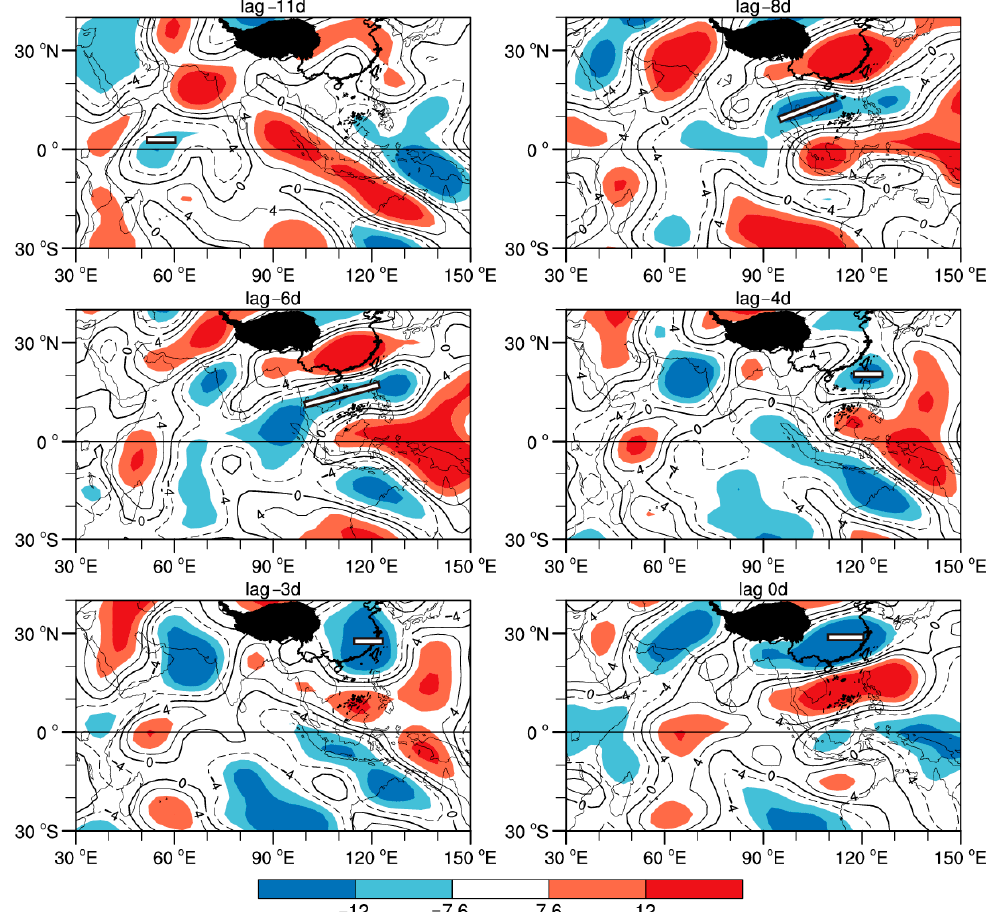
Figure 8. Composite of lead–lag correlation coefficients (shaded and contours, 10 − 2 ) between LF OLR 11~0 days ahead and LF summer precipitation time series of flood years in southern China (shaded areas significant at α = 0.1 level), the expression of negative days indicates that the LF OLR is ahead of the LF precipitation. The black area represents the masking of the Tibetan plateau. “ − ” represents the convective active region affecting the LF precipitation on 0 days in southern China.